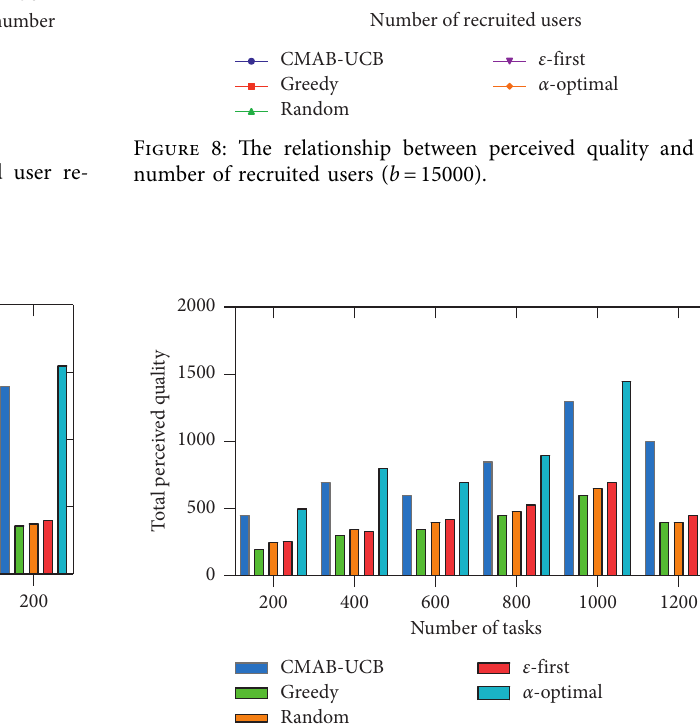
Figure 6: The relationship between perceived quality and the number of recruited users ( b � 5000).